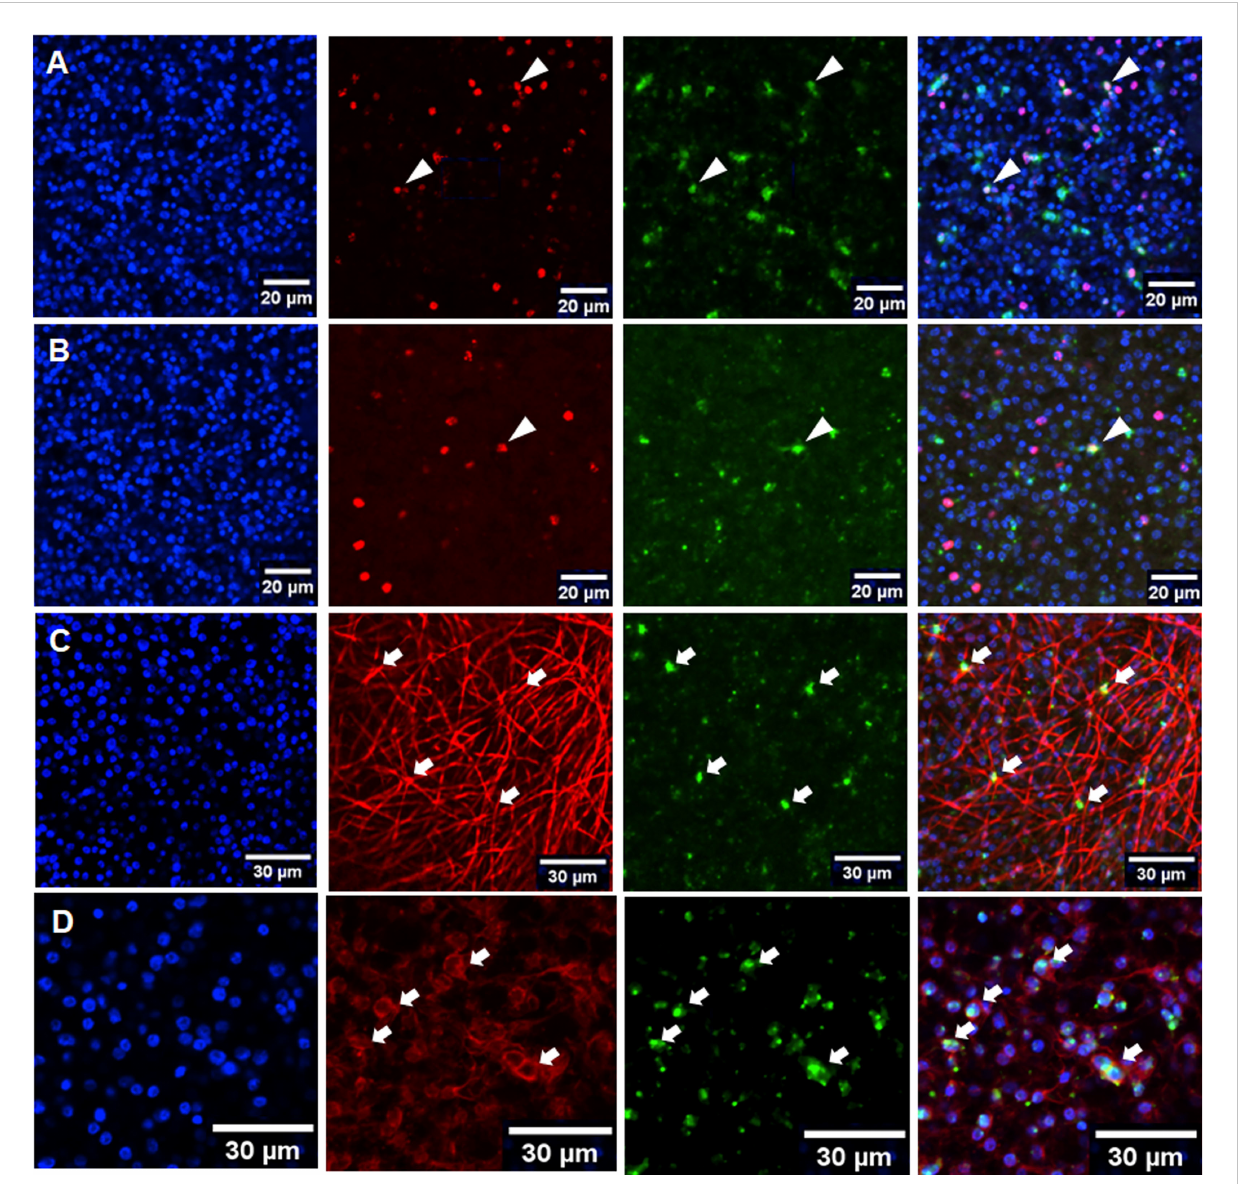
FIGURE 7 Expression of Emact within the metacestode GL. Representative WISH images are shown for Emact expression in the GL of axenically cultivated vesicles (A) and vesicles from co-culture (B) as well as in muscle (C) and nerve cells (D) from co-cultured vesicles. Channels indicate DAPI (nuclei, blue), Emact -speci fi c probe (green), EdU (S-phase stem cells, red; (A, B) ), anti-HMW tropomyosin (muscle fi bers, red; (C) ), and anti-AcTub (nerve cells, red; (D) ). Merges of all three channels are shown in right panel. Cells double positive for Emact and EdU are indicated by white triangles (A, B) , double positive for HMW tropomyosin and Emact by white arrows in (C) , and double positive for Emact and AcTub by white arows in (D) Bar indicates 20 µm in (A, B) and 30 µm in (C, D)